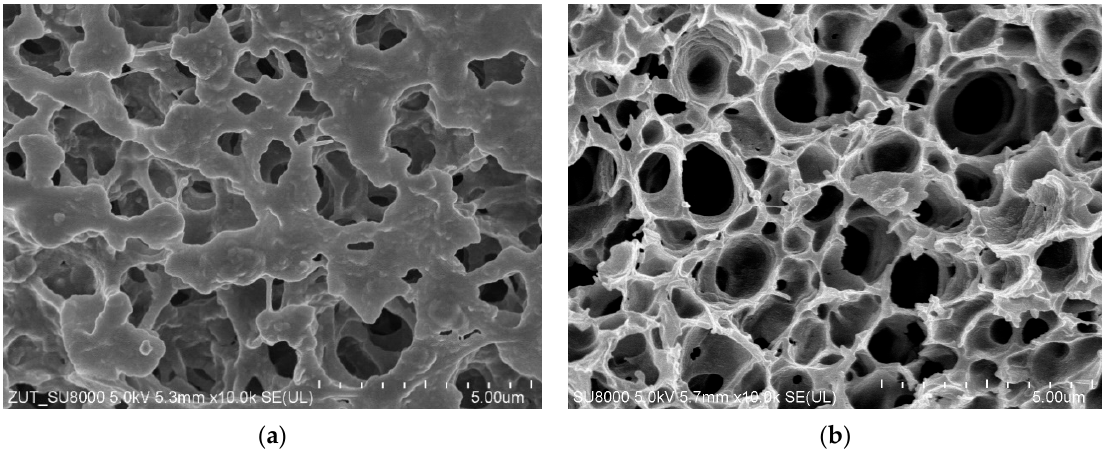
Figure 3. SEM images of membranes: ( a ) surface; ( b ) wall cross-sections. Magnification ×10,000.